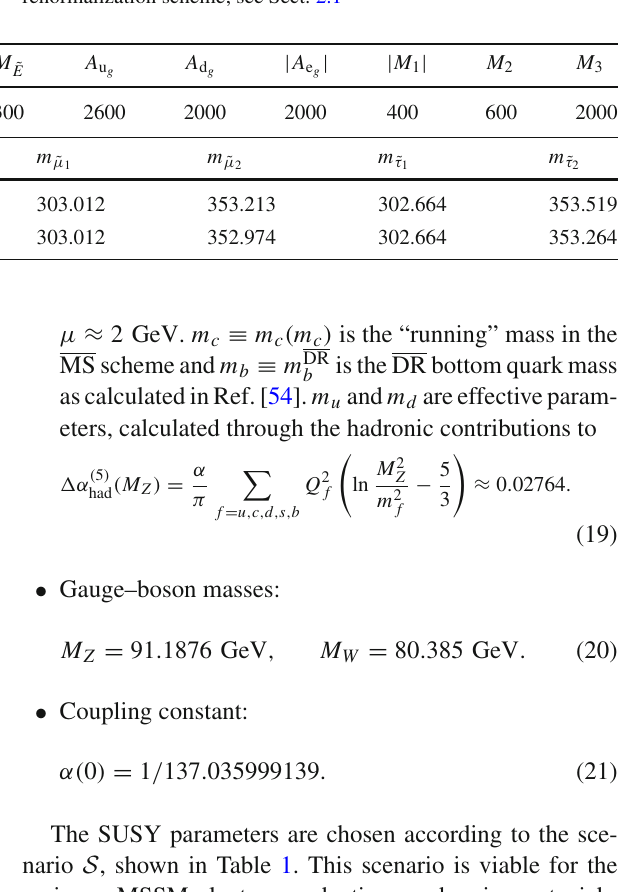
= 2000 GeV for all squark generations, and mon values M ˜ Q , ˜ U , ˜ D = M ˜ + 50 GeV for all slepton generations. For the sleptons M ˜ L E we show the tree-level values as well as their OS masses in our DR[2] g renormalization scheme; see Sect.